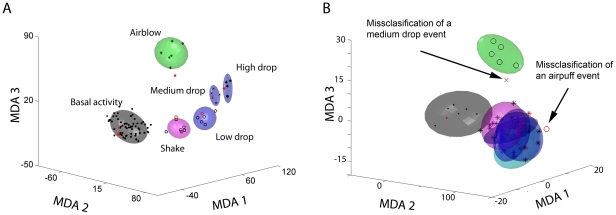
Shuffling of the data leads to the collapse of classification of
population patterns.Scrambling technique revealed large overlap between the drop, shake and
rest clusters (B) in comparison to the distinct clusters prior to
shuffling (A). When the neural activities collected during events were
shuffled among different units, the overall cluster structure collapses.
In the case of air cluster, data shuffling leads to the
misclassification and poor prediction of the test data (see the open
circle symbol from an air-blow testing data was totally
misclassified).